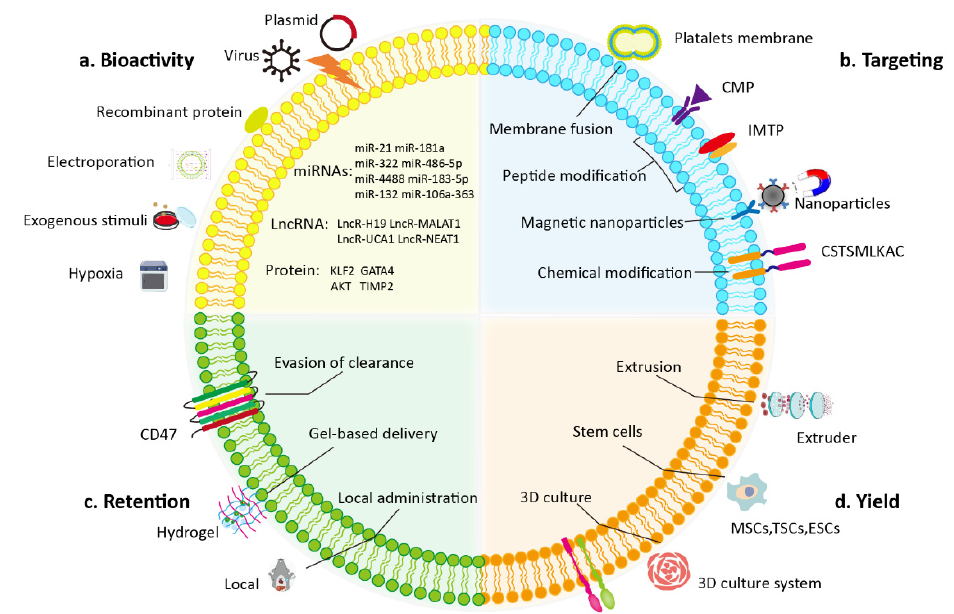
Figure 2. Modulation of EVs for cardiac therapies. Various engineered approaches have been developed to amplify the therapeutic effects of EVs by increasing the bioactivity, targeting, retention, and yield of EVs. Manipulating parental cells or direct modification of the isolated EVs is involved in bioengineering of EVs. Both genetic and nongenetic methods participate in modification strate- gies.